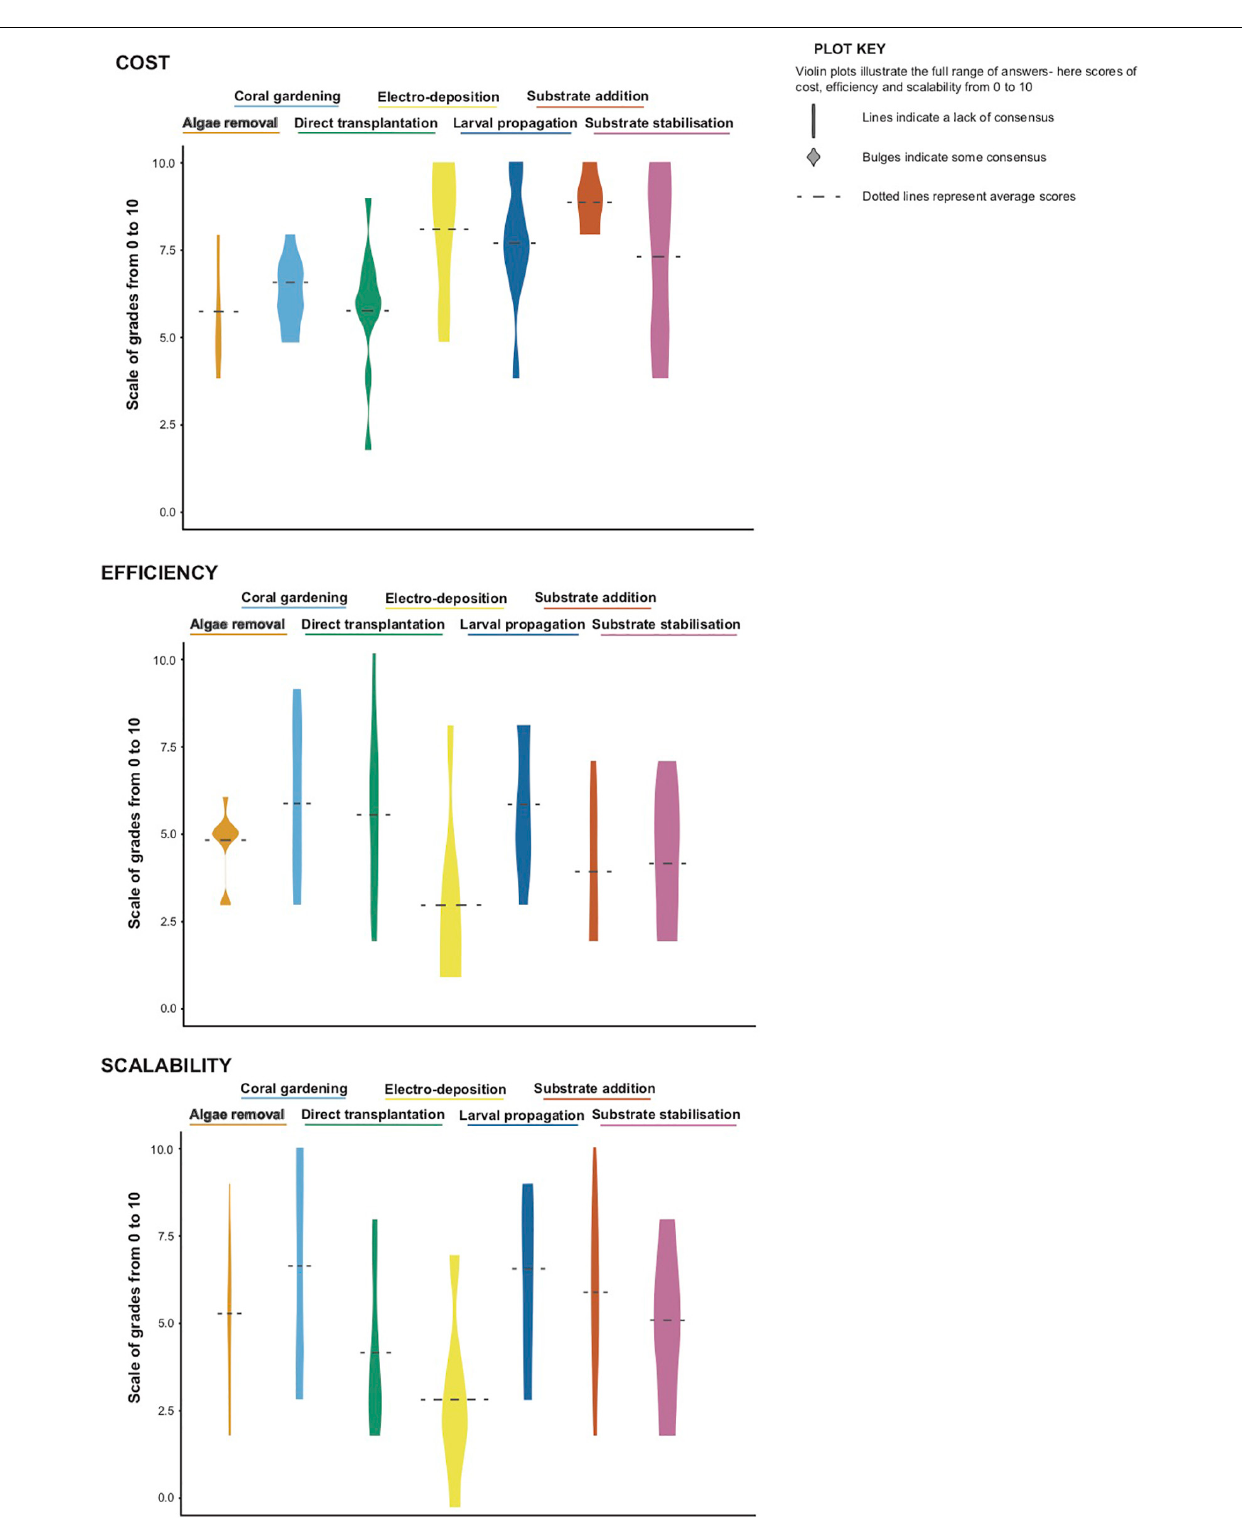
Frontiers in Marine Science |